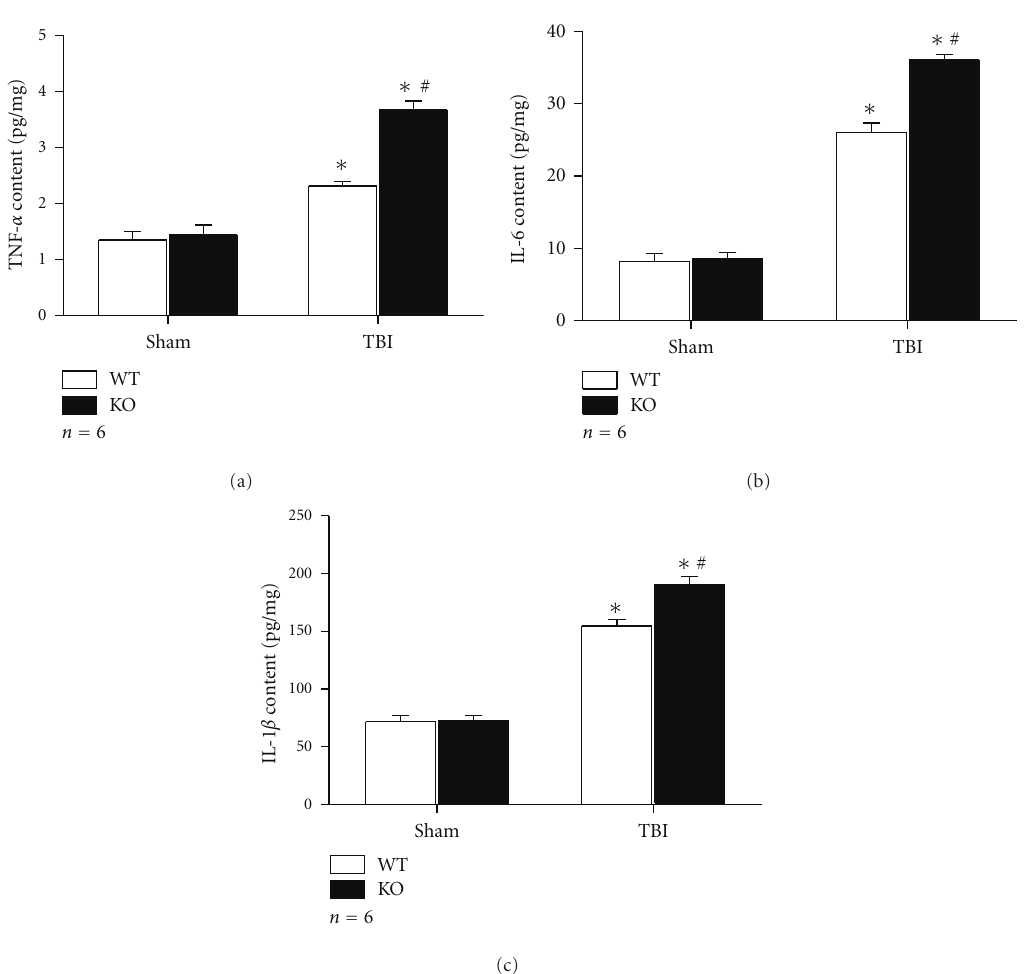
Figure 4: ELISA analysis of protein level of proinflammatory cytokines. ELISA results revealed protein level of these cytokines were elevated in astrocytes after scratch as compared with sham control ( P < 0 . 01). And they were much higher in Nrf2 KO astrocytes than in their WT counterparts ( P < 0 . 01). (a) TNF- α . (b) IL-6. (c) IL-1 β ( ∗ P < 0 . 01, compared with sham counterpart; # P < 0 . 01, compared with WT